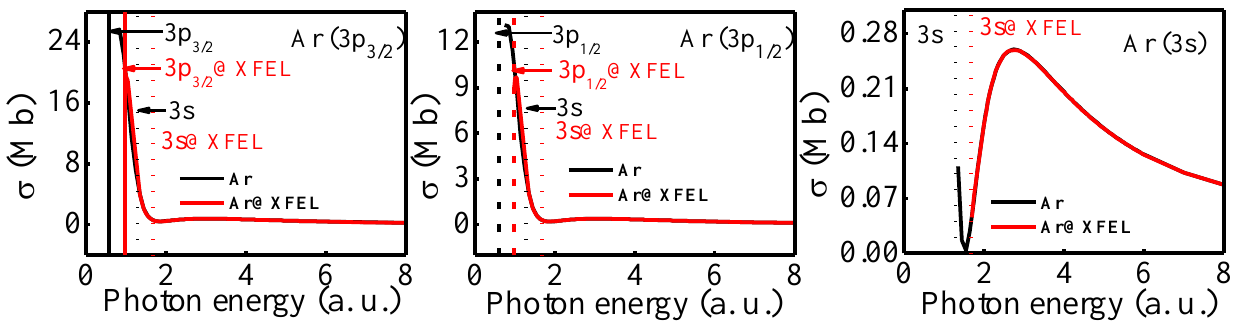
Figure 7. Photoionization cross section (σ) of 3p 3/2 (Left), 3p 1/2 (Middle), and 3s (Right) subshells of Ar (black) and Ar@XFEL (red). Solid, dashed, and dotted vertical lines represent the threshold for 3p 3/2 , 3p 1/2 , and 3s thresholds of free (black) and confined atom (red), respectively.